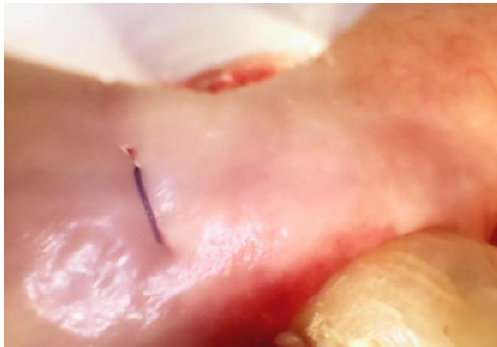
Figure 5. A Videoscope-Assisted Minimally Invasive Surgery (VMIS) palatal flap closed with a single vertical mattress suture at the base of the papilla. The edges of the incision in the papilla have been approximated with finger pressure only.